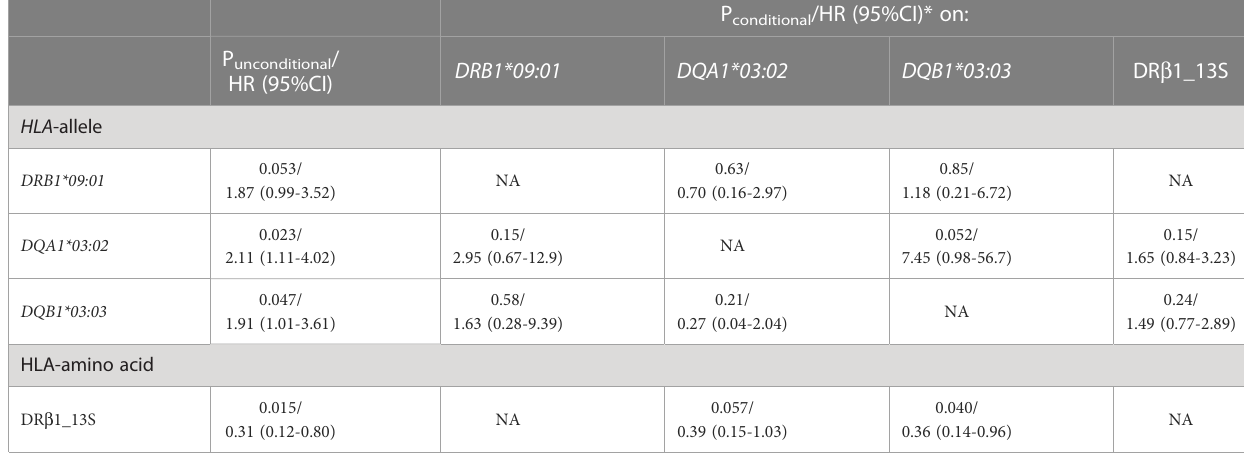
P conditional /HR (95%CI)*